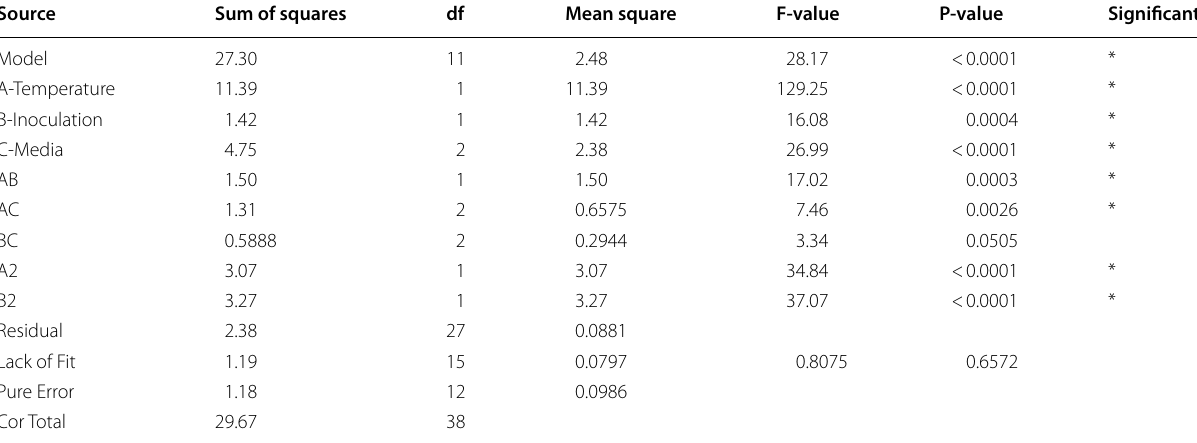
Table 3 ANOVA analysis of SAK expression in dicistronic Hsp27 SILEX system by the second order polynomial model Source Sum of squares df Mean square Model